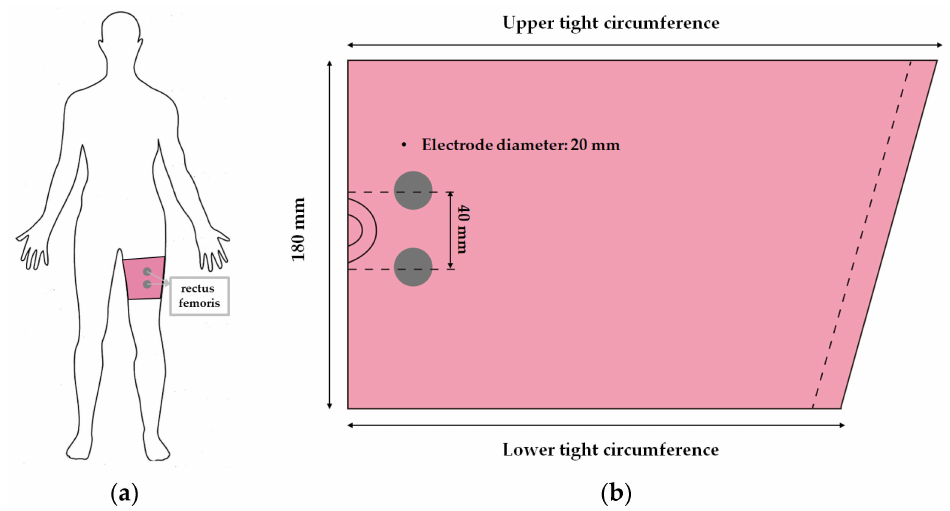
Figure 1. Scheme of ( a ) rectus femoris, which is muscle activation position, and ( b ) fabrication of leg sleeves with embedded textile-based dry